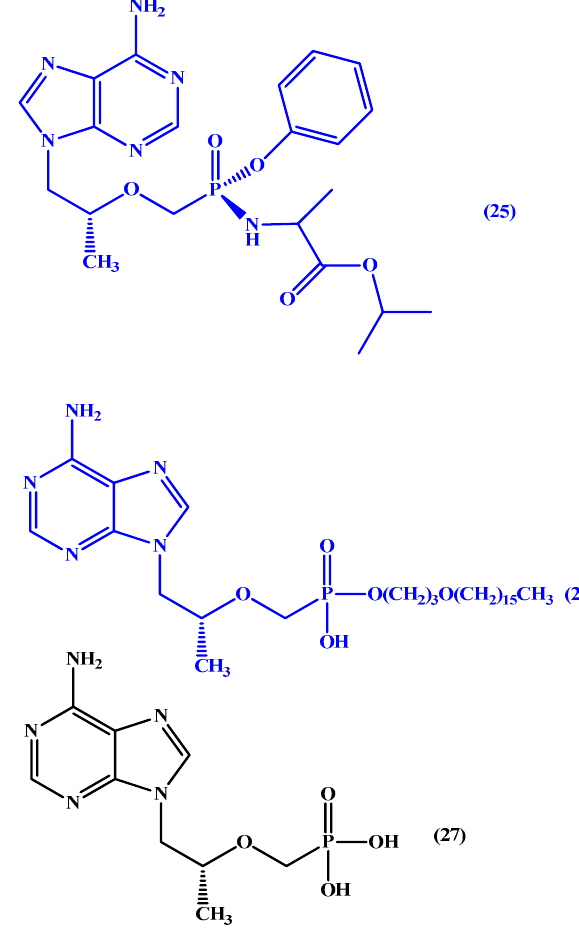
Figure 13. Chemical structures of tenofovir prodrugs, tenofovir alafenamide ( 25 ), CMX157 ( 26 ) and parent drug tenofovir ( 27 ).